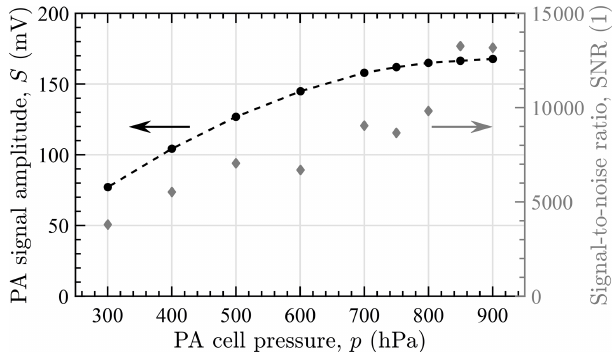
Figure A1. PA signal and signal-to-noise ratio as a function of the pressure of the PA cell operated at 35 ◦ C. Signal measurements were performed with humidified air at a water vapor mole fraction of 18760 ( 120 ) ppm and with an averaging time of 1s. Noise used in the SNR calculation was determined from background signal mea-